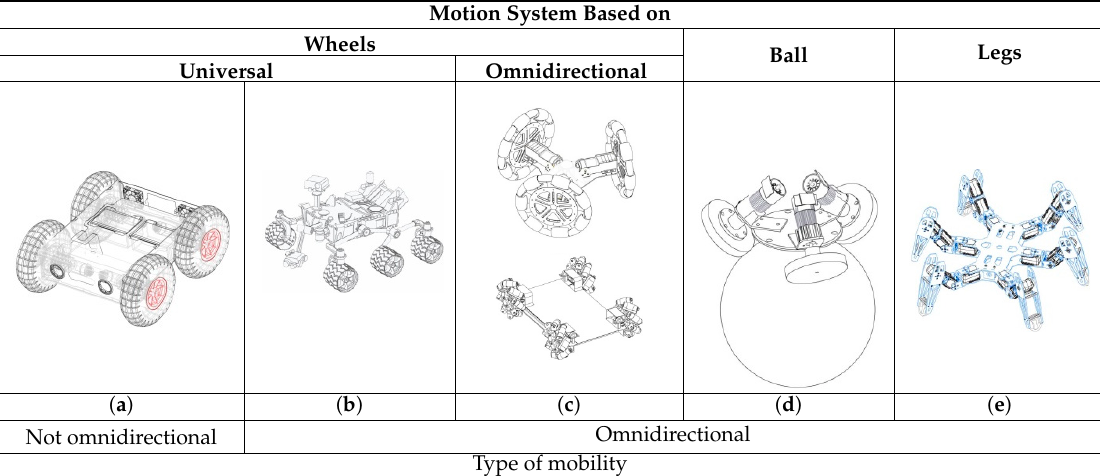
Table 1. Classification of mobile robots based on the motion system and type of mobility.